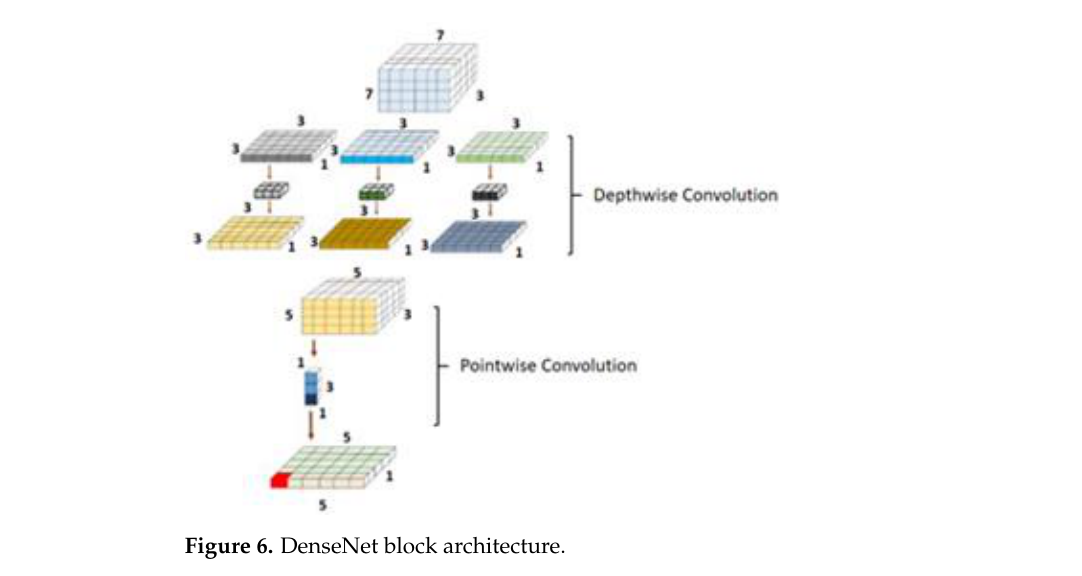
Figure 5. ResNeXt Architecture.